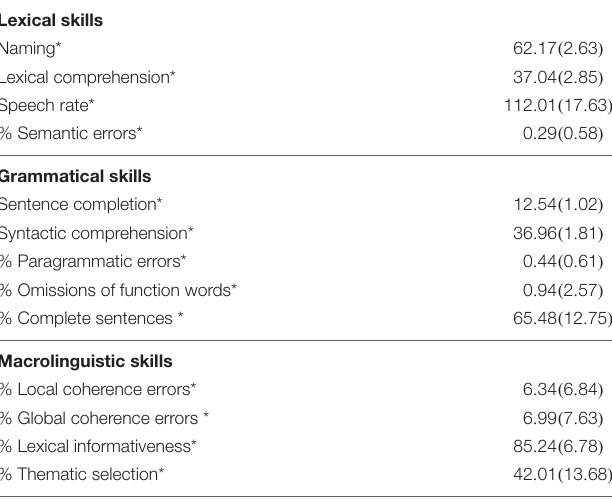
TABLE 6 | Results of the analysis of lexical, grammatical, and macrolinguistic skills in the reduced group of participants with Typical Language